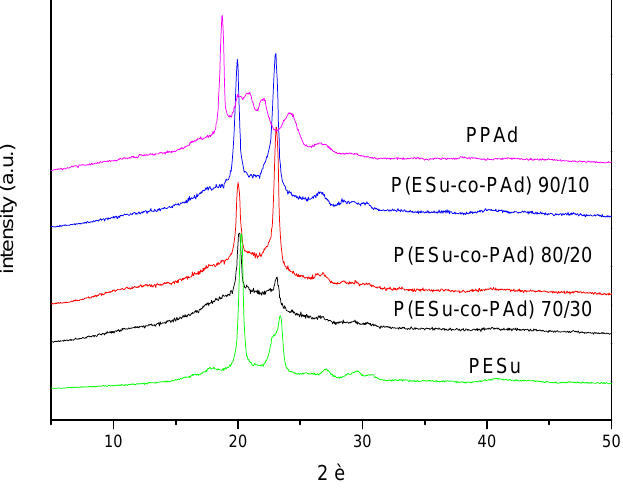
Figure 4. WAXD patterns of the PESu, PPAd and crystalline P(ESu-co-PAd)